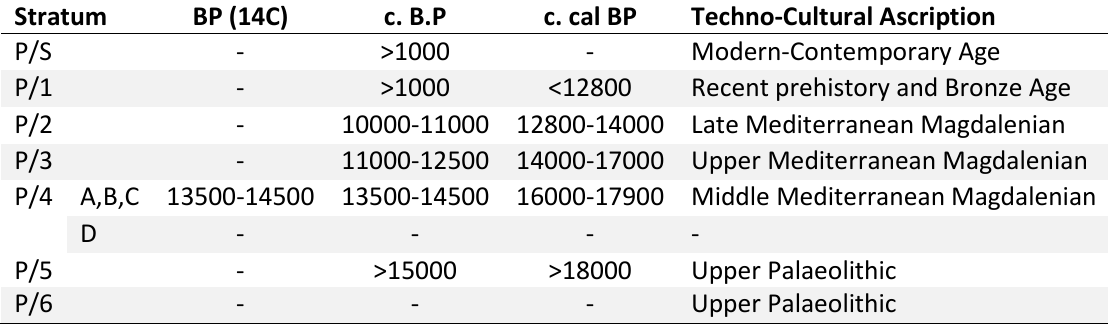
Table 1. Chronological and culture sequence